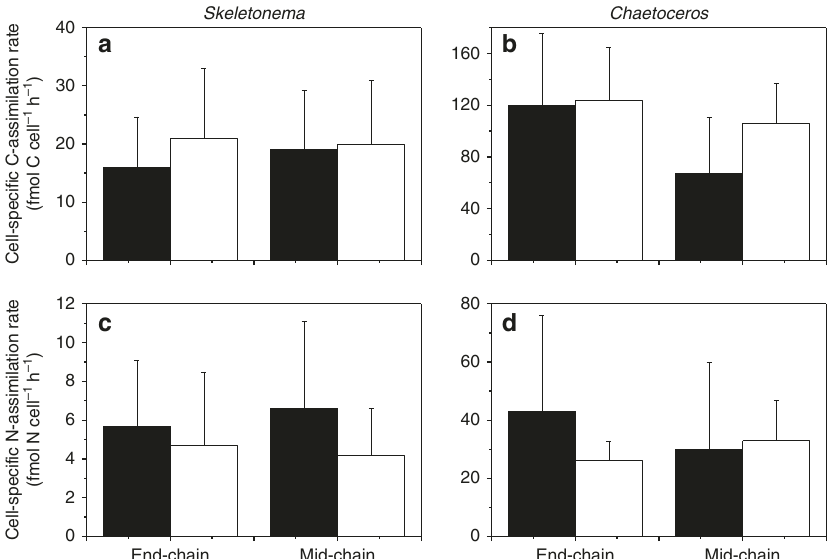
Fig. 4 C- and N-assimilation rates depending on position within cell chains. Cell-speci fi c C- and nitrate (N) assimilation rate measured in cells positioned at the end or in the middle of cell chains (>7 cells chain − 1 ). Skeletonema ( a , c ) and Chaetoceros ( b , d ) under still (black bars) and turbulent conditions (open bars). The bars represent the mean value and the error bars one standard deviation ( n = 7 –